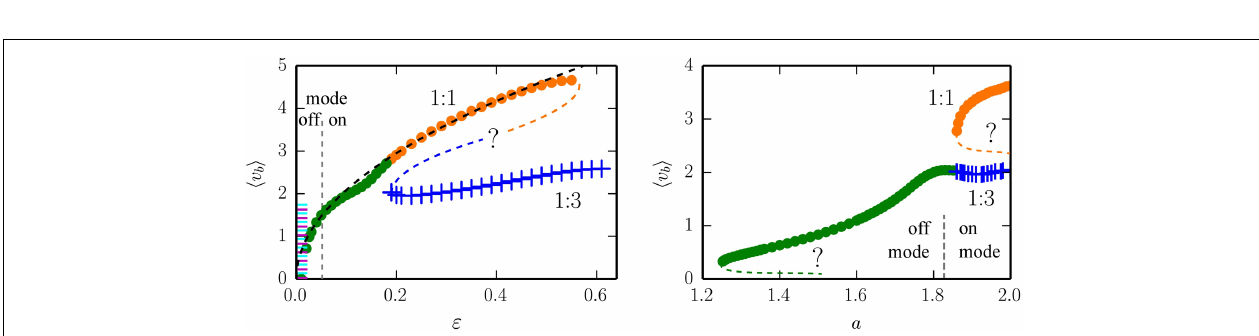
FIGURE 4 | The motion x ( t ) of the mass along the rod of the one-rod barrel (top row), together with the corresponding phase-plane trajectories ( x ( t ), v b ( t )) (bottom row), compare Figure 2 . The gain and the adaption rate are a = 1.9 and ε = 0.25, respectively. Shown are the 0:1, 1:1, and 1:3 modes (left/middle/right column). Note that the velocity v b ( t ) of the barrel vanishes for the 0:1 mode, oscillating but remaining otherwise positive for the 1:1 and the 1:3 mode. For the corresponding videos, see the Supplementary Material.